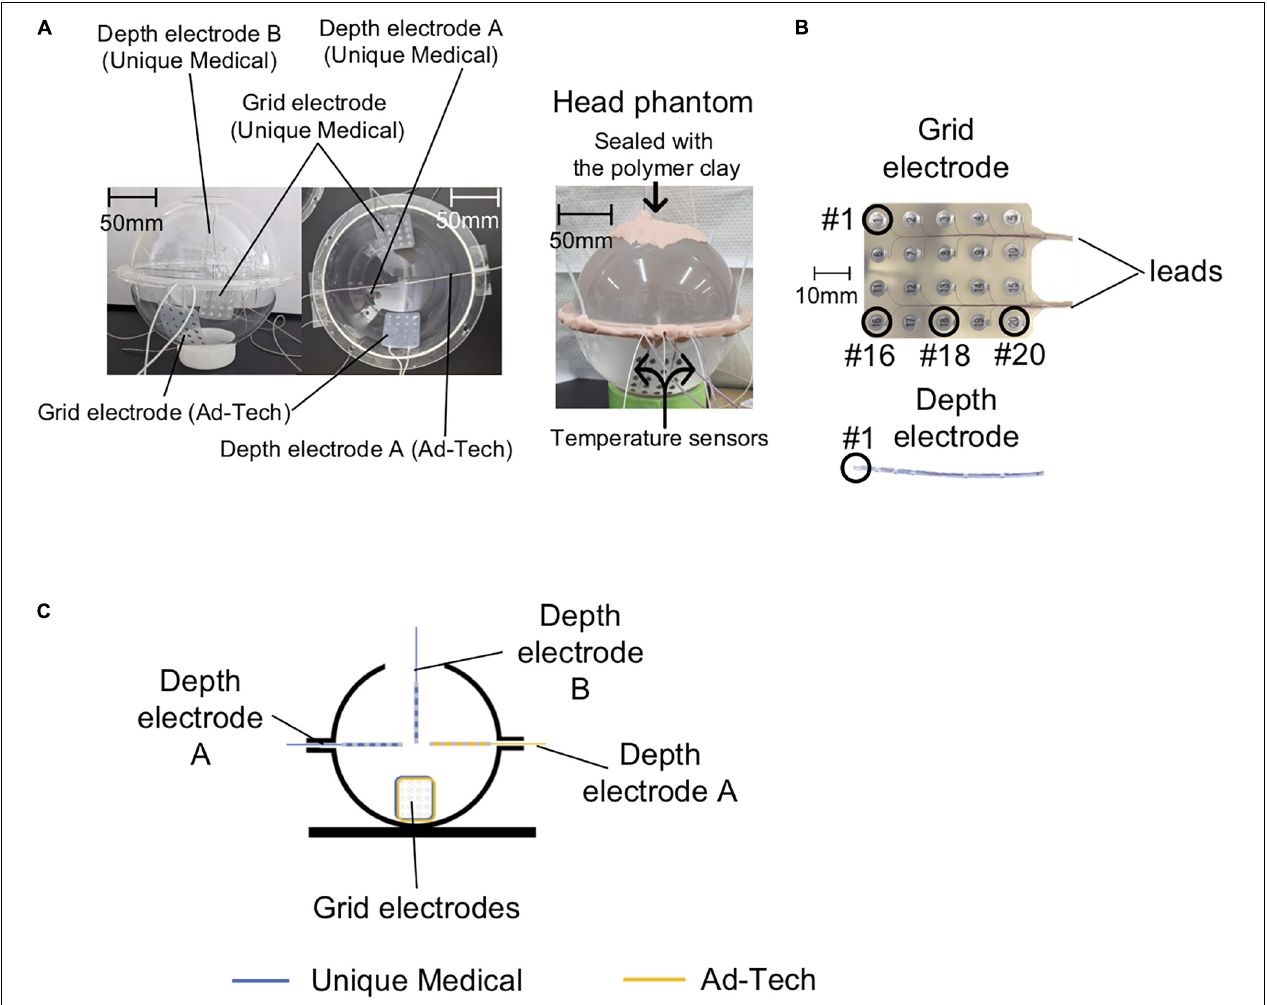
FIGURE 1 | Phantom preparation. (A) Left panel: Photos of the empty acrylic shells are shown here to clarify the position of each electrode in the head phantom. Two Unique Medical depth electrodes were placed in the acrylic shells: one was quasi-perpendicular (depth electrode A) and the other was quasi-parallel (depth electrode B) to the grid electrode. Only one Ad-Tech depth electrode was implanted, which was quasi-perpendicular to the grid electrode (depth electrode A). Right panel: photo of the head phantom that was ready for use in experiments of both the temperature and voltage measurements. (B) Electrode contact numbering. In the case of grid electrodes, #1 represents the contact at the right corner and the most distal from the leads, and #20 represents the contact at the left corner and the most proximal to the leads. In the case of depth electrodes, #1 represents the contact at the tip. (C) The head phantom as represented in a two-dimensional line